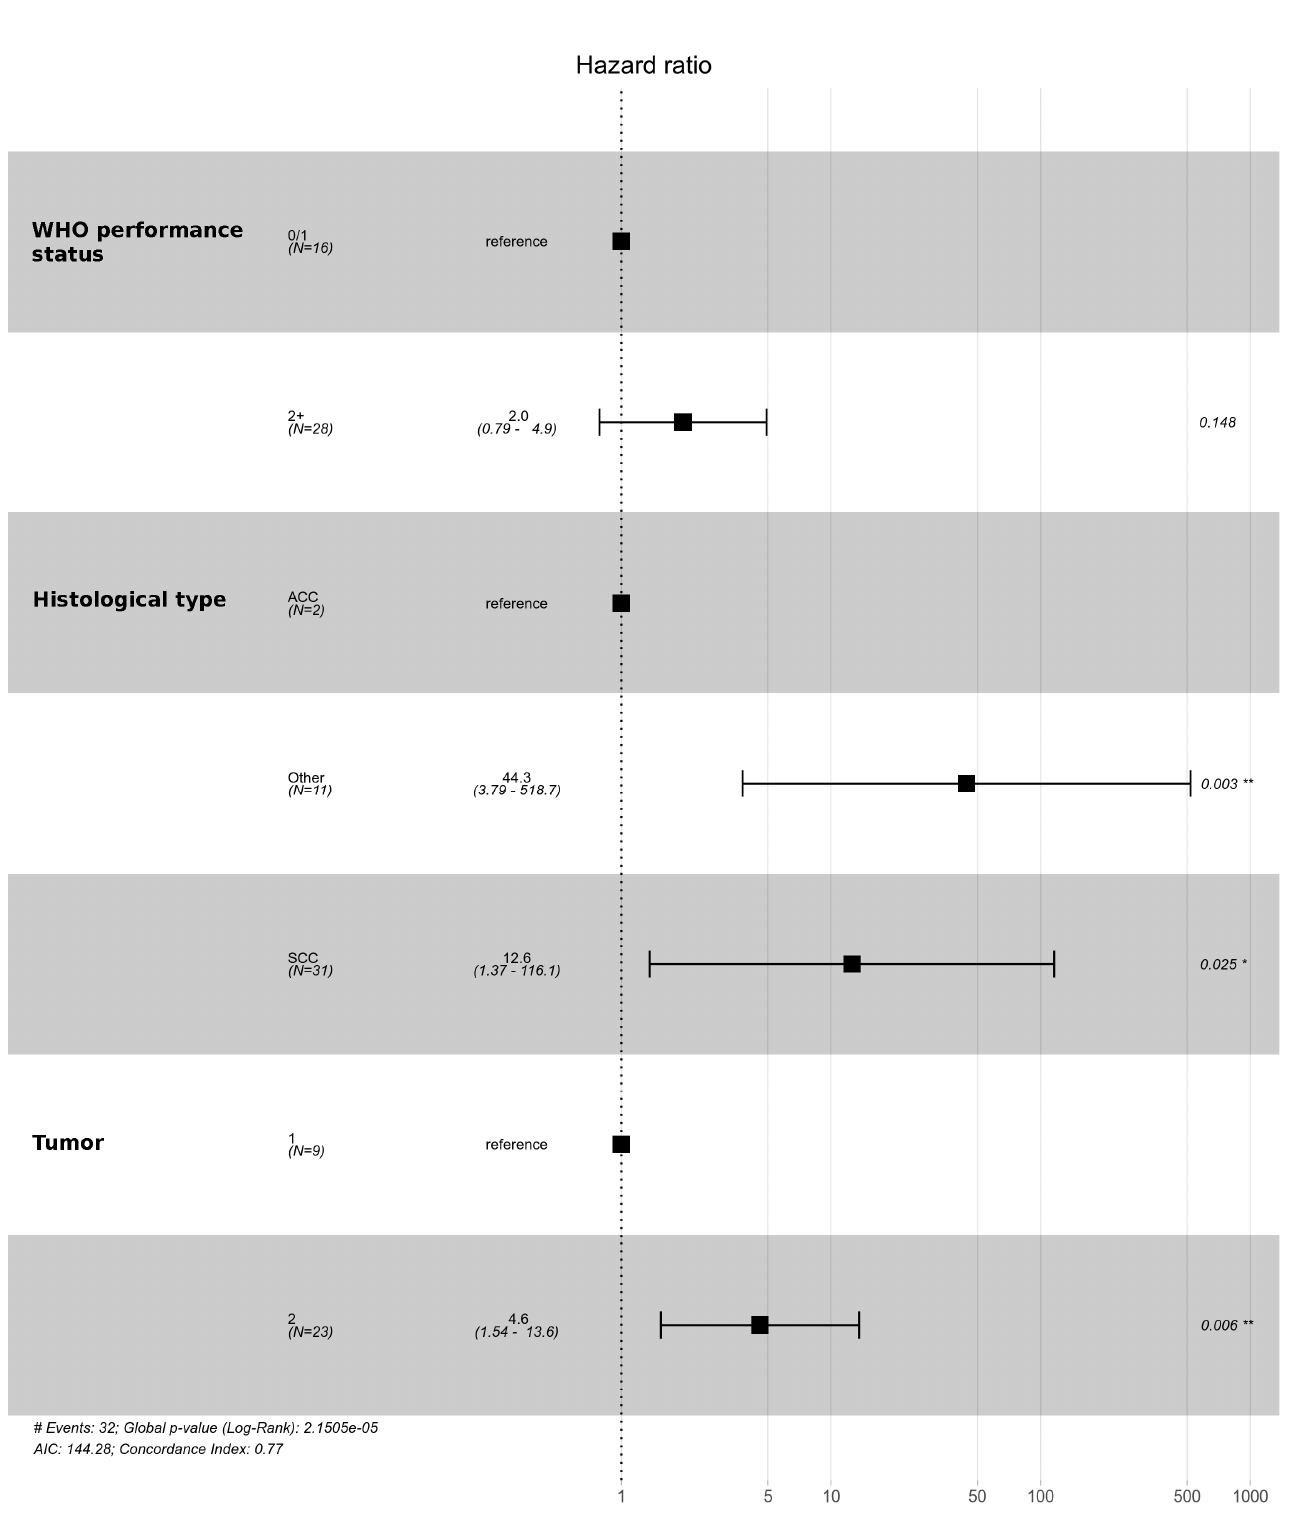
Figure 7. Multivariate analysis for overall survival among palliative care patients. Significant codes legend: from 0.001 to 0.01 “**”; from 0.01 to 0.05 “*”.